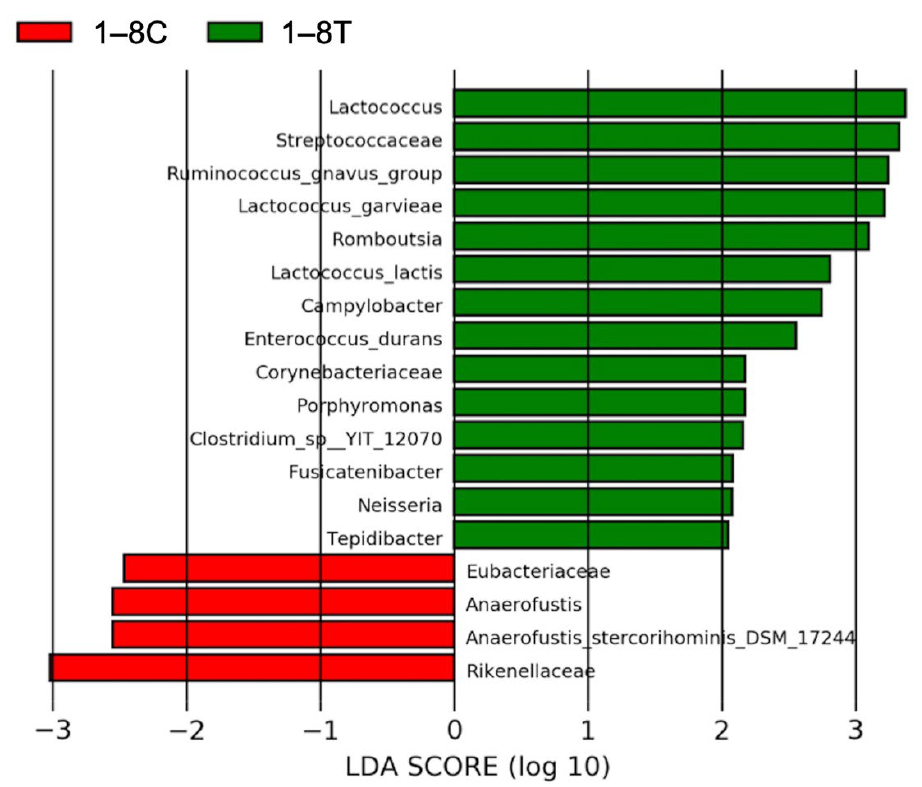
Figure 6. The linear discriminant analysis (LDA) scores based on linear discriminant analysis effect size (LEfSe) results before (red) and after (green) Bacillus licheniformis -fermented products (BLFP) administration in diarrheal cats. C: before the BLFP treatment; T: after the BLFP treatment.